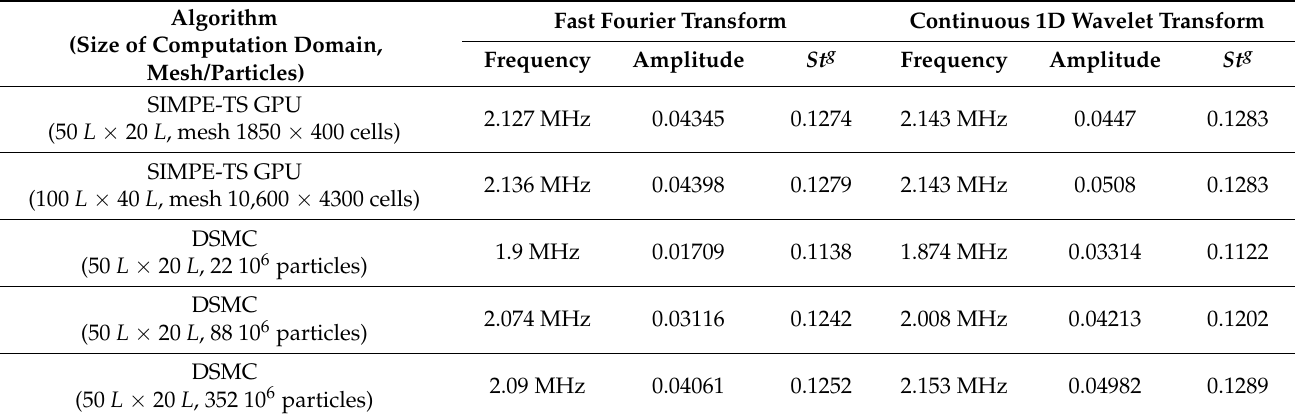
Table 1. Comparison of frequencies, amplitudes, and Strouhal numbers of lift coefficients at estab- lished regime obtained by SIMPLE-TS GPU (continuum approach) and DSMC (molecular approach) and analyzed by FFT and